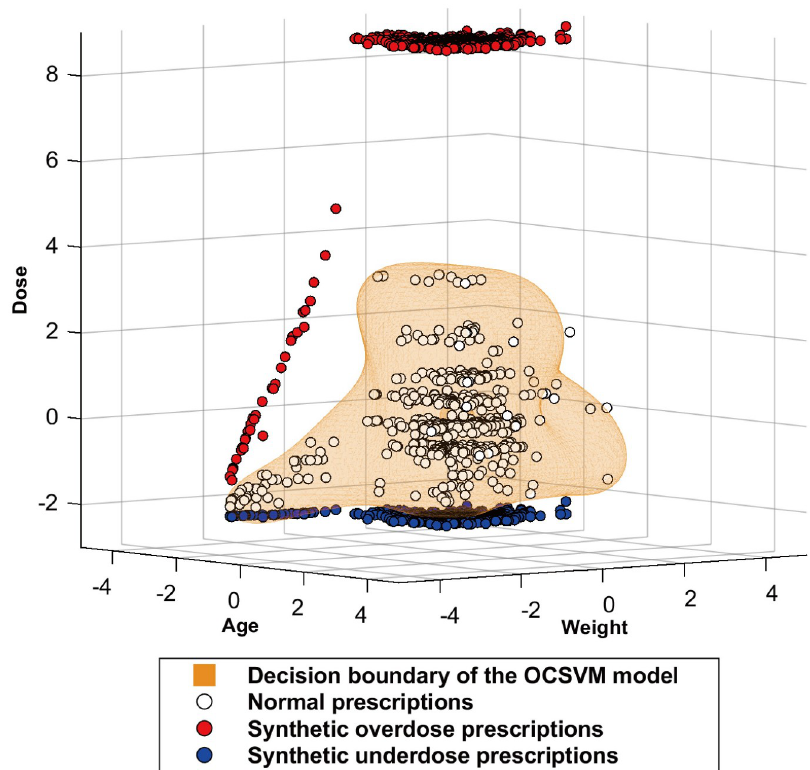
Fig 1. Decision boundary of the OCSVM model and individual data for acetaminophen fine granules. Data are represented as standardized values.